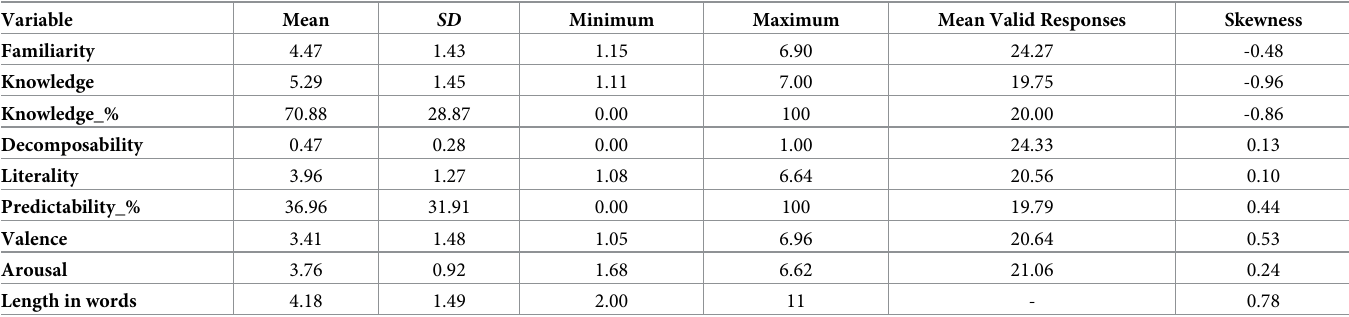
Table 1. Descriptive statistics of the variables in the